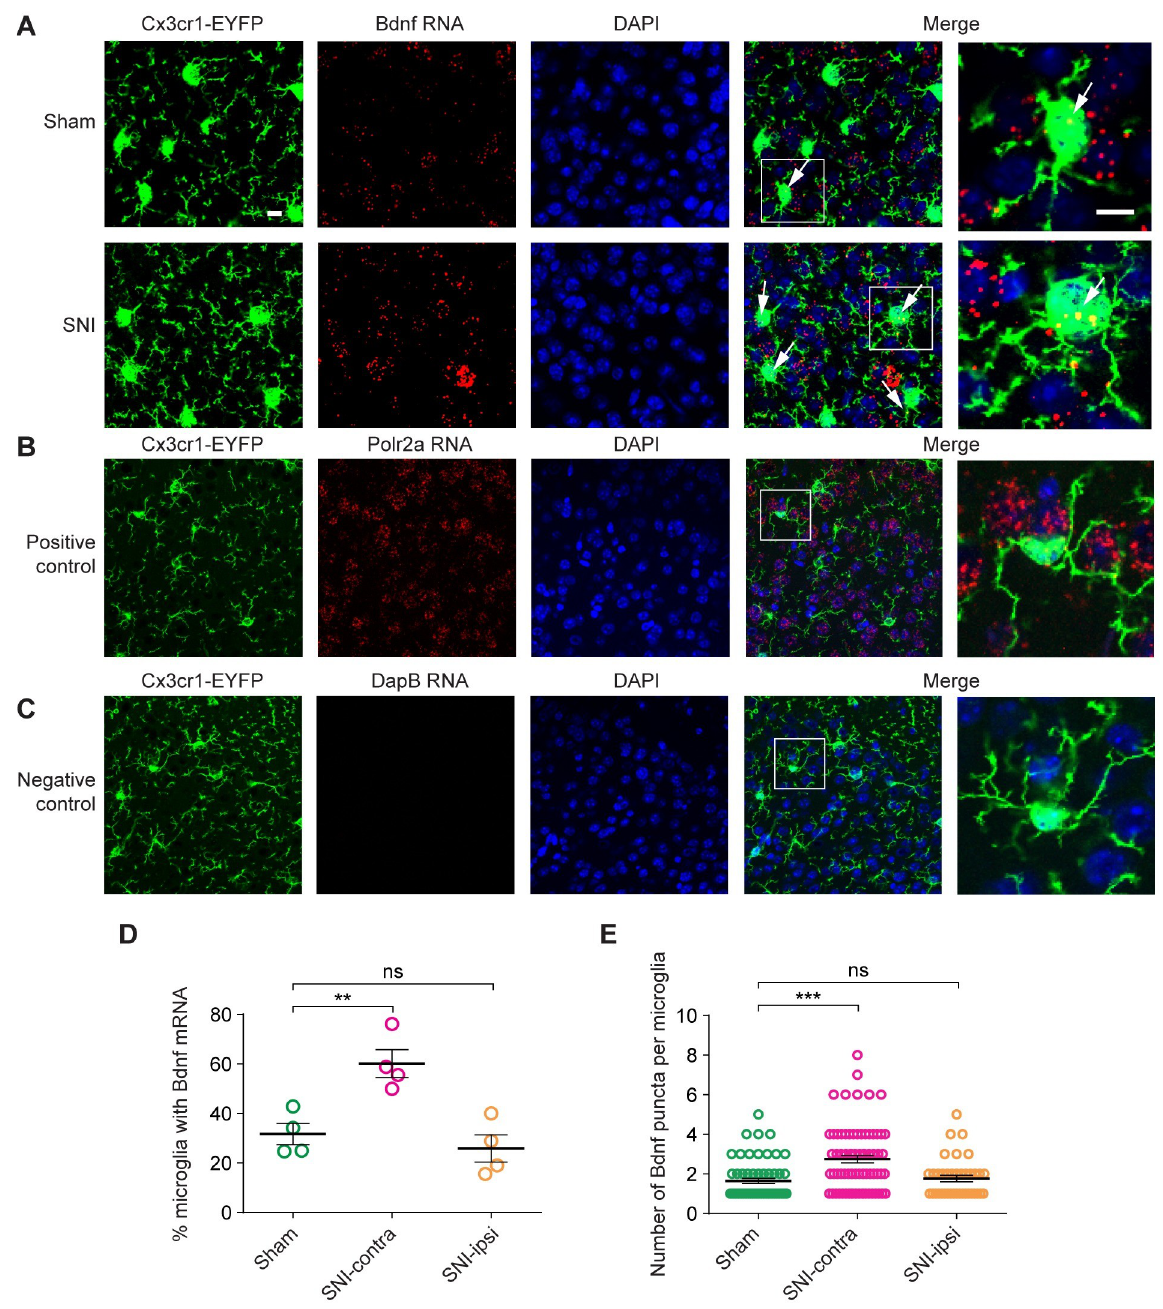
Fig 2. Validation of microglial Bdnf through RNAscope fluorescence in situ hybridization. ( A ) RNAscope fluorescence in situ hybridization in the S1. Red color represents Bdnf mRNA probe hybridization. Green color indicates Cx3cr1 -EYFP + microglia. Blue, DAPI. Arrows indicate Bdnf transcripts located within microglia. Scale bar, 10 μ m. ( B ) Positive control probes for in situ hybridization, targeting mRNA for the ubiquitously expressed housekeeping gene Polr2a ; images show representative signal in S1. ( C ) Negative control probes targeting mRNA for DapB , a gene expressed in Bacillus subtilis . ( D ) Percentages of microglia with the presence of Bdnf mRNA ( n = 4 mice per group, F 2, 9 = 12.49, P = 0.0025). ( E ) Number of Bdnf puncta per cell among microglia with detectable Bdnf transcripts ( F 2, 168 = 13.63, P < 0.0001). Summary data are presented as mean ± SEM. �� P < 0.01, ��� P < 0.001, ns, not significant; by one-way ANOVA followed by Tukey multiple comparisons test ( D , E ). ( A-C ) Representative images from experiments carried out on 4 animals per group. The data underlying this figure can be found in S1 Data. Bdnf , brain-derived neurotrophic factor; SNI, spared sciatic nerve injury; S1, primary somatosensory cortex.